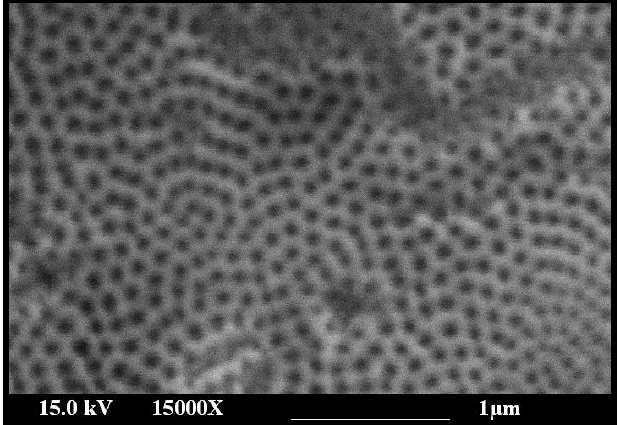
Fig. 1. Surface morphology of the TiO in the two-step anodization process.